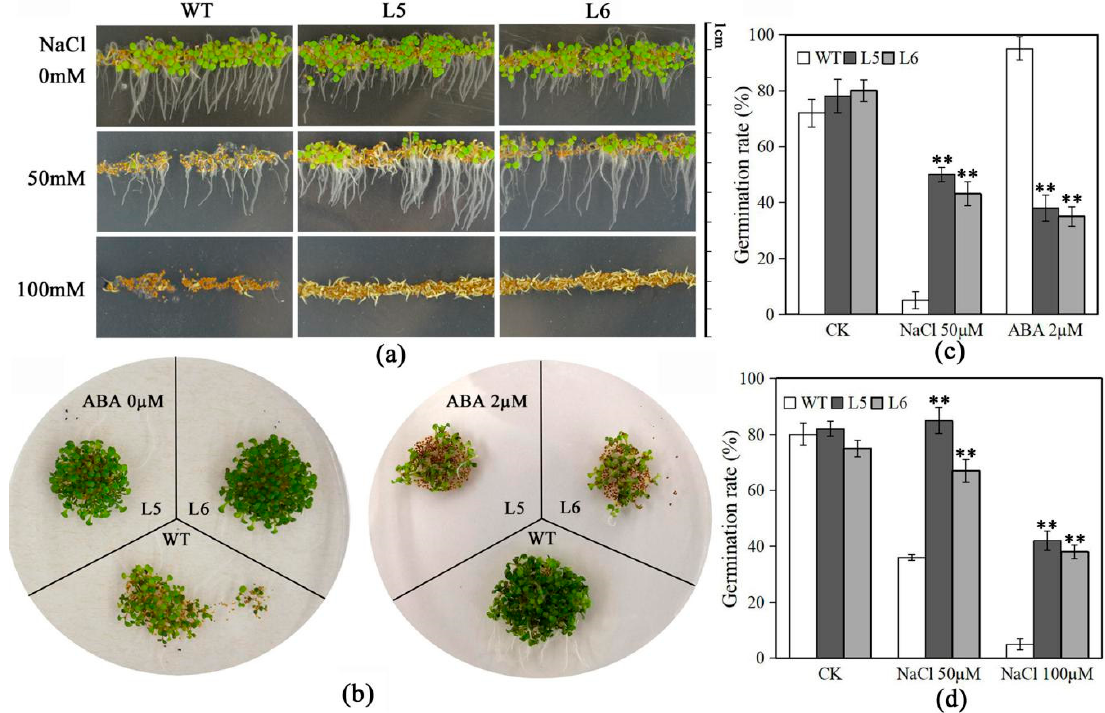
Figure 8. LlNAC2 transgenic lines showed ABA hypersensitivity and enhanced salt tolerance. Germination of WT of Col-0 and 35S-LlNAC2 seeds on MS supplemented with ( a ) 50 mM or 100 mM NaCl and ( b ) 2 µ M ABA assayed by both ( c ) cotyledon greening and ( d ) radicle protrusion. For ( a ) and ( b ), images were acquired after 7 days of incubation at 22 °C. Three biological replications were performed. The bars show the SD. Asterisks indicate a significant difference ** p < 0.01 compared with the corresponding controls.